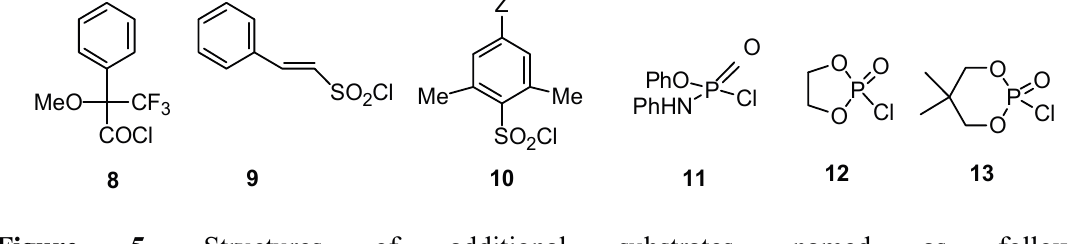
Figure 5. Structures of additional substrates, named as follows: α -Methoxy- α -(trifluoromethyl) phenylacetylchloride ( 8 ); trans - β -styrenylsulfonyl chloride 2-chloro-1,3,2-dioxaphospholane-2-oxide ( 12 ); 2-chloro-5,5- dimethyl-1,3,2-dioxaphosphorinane-2-oxide ( 13